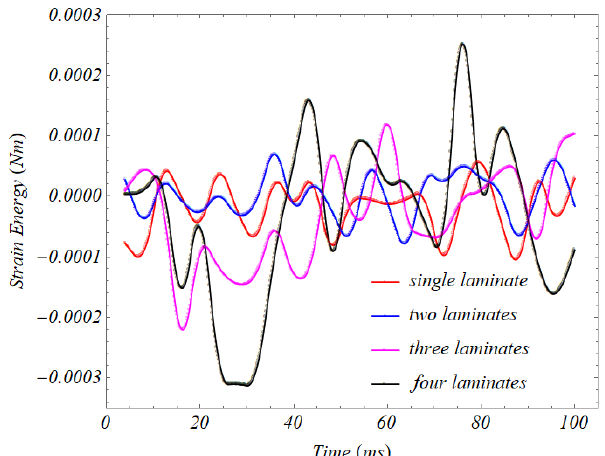
Fig. 11. Strain energy against time for various number of cellphone casing. laminates at 2500mm drop distance